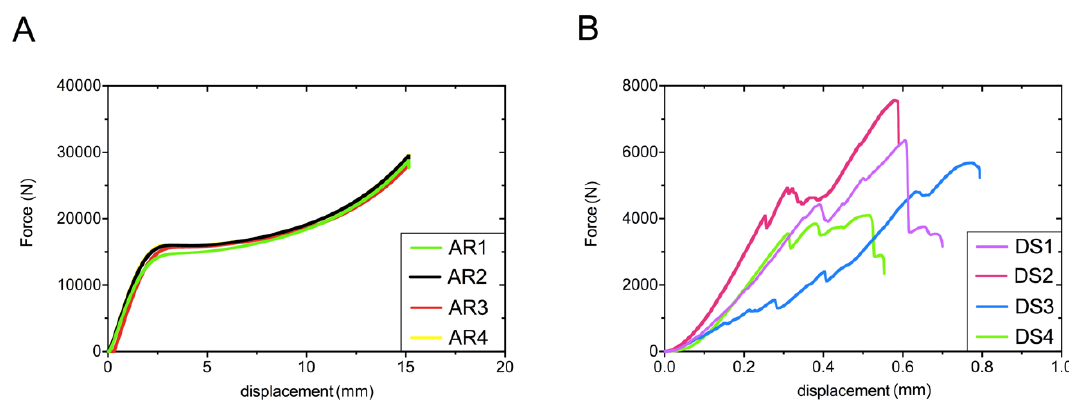
Figure 6. The force / displacement curves of acrylic ( A ) and stone samples ( B ) obtained during static compression test. AR and DS means acrylic resin and dental stone, respectively (1–4 are the numbers of tested specimens).